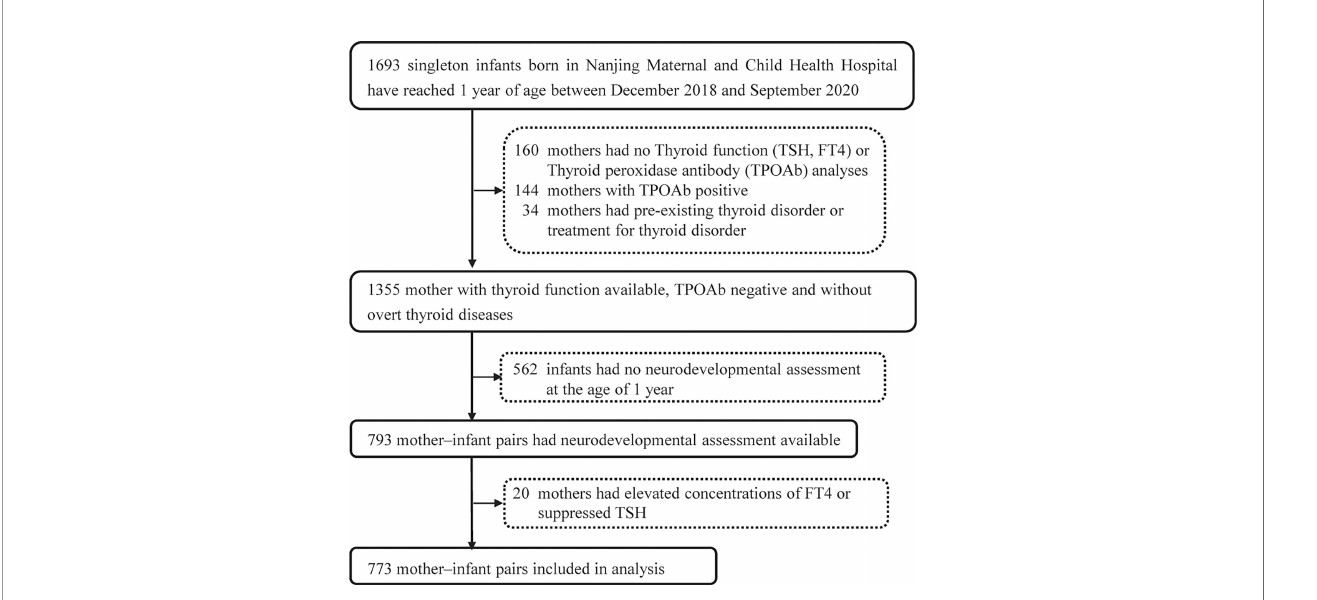
FIGURE 2 | Flowchart of participants through the study. TSH, thyroid-stimulating hormone; FT4, free